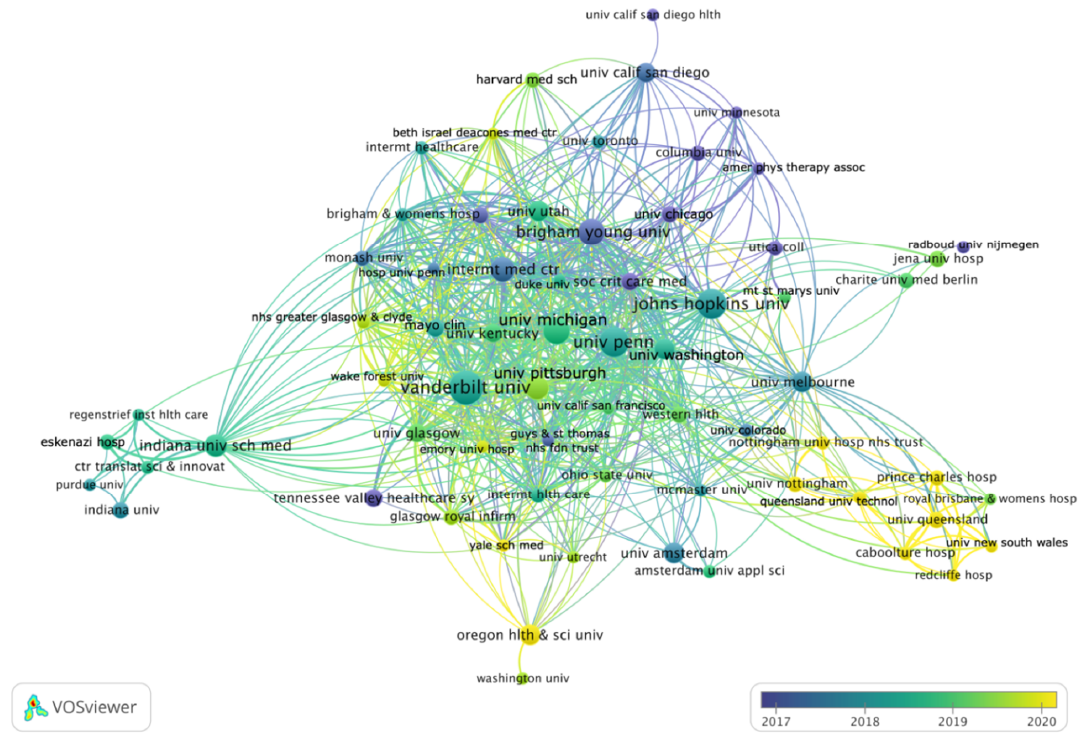
Figure 4. Collaborations between institutions among articles on post-intensive care syndrome. Co- authorship-based network. Lines between institutions indicate direct links (i.e., co-authorships). Thicker lines are indicative of stronger links (i.e., more co-authorships). The further two institutions are apart, the weaker is their relation. Colors indicate the average publication year of an institution’s articles. Institutions with at least four publications are shown. Five institutions were excluded as they did not show any connection with the network. Created using VOSviewer.